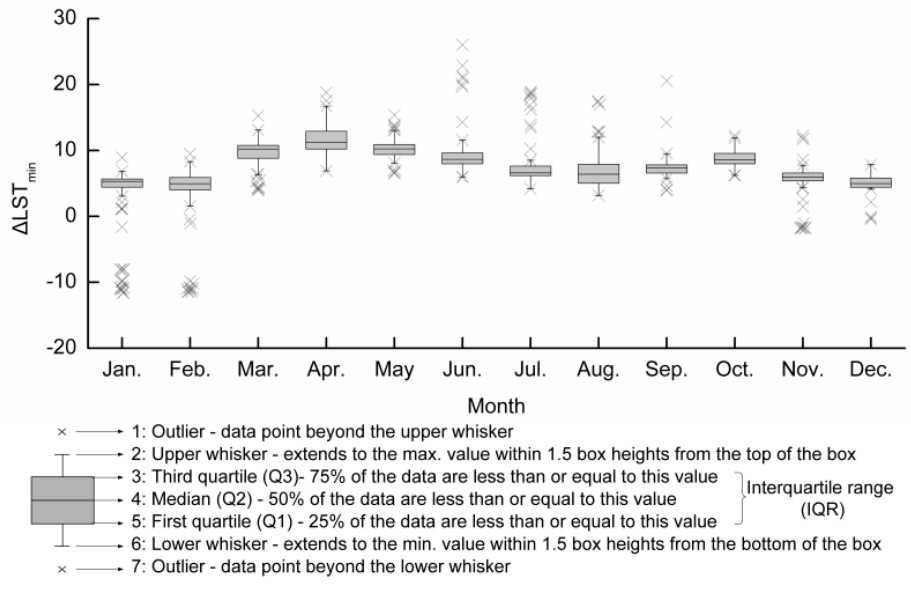
Figure 5. The monthly box plots of ∆ LST min points and the separated outliers (cross dots) in 2005. As soon as the outliers were removed from ∆ LST min , the monthly wet edges from 2000 to 2010 were rebuilt using the remaining data. As an example, the improved wet edges and their fitting equations in 2005 are shown in Figure 6. The isolines of wet edges from January to December in 2005 are almost all horizontal lines, and they change slowly with variations in the NDVI. Their slopes are in the range of − 2.33–1.32, and the intercepts of the fitting equation in each month is close to the median of the corresponding ∆ LST min , which is an optimal theoretical condition. Therefore, the improved wet edges are closer to the theoretical isolines than are the original simulated wet edges, as the theoretical isolines of wet edges are constant and do not vary with the NDVI. After removing the “tail down” points from the dry edges, the modified equations of least squares regression were obtained from the ∆ LST max points, with the NDVI in the range of 0.1–1.0. This process optimized the goodness of fit of the regression equation, and the coefficients of determination ( R 2 ) in each month ranged from 0.86–0.96, which is higher than before (Figure 6).